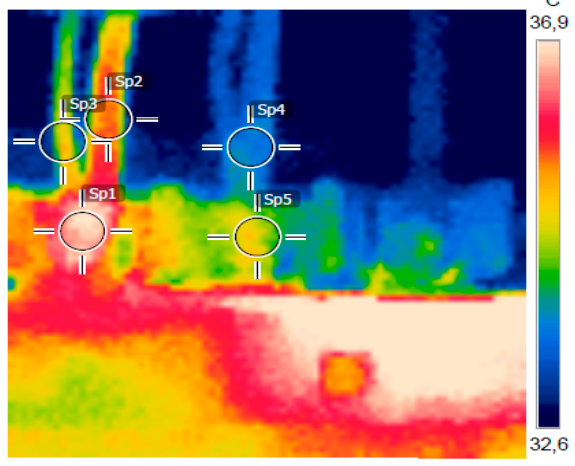
Figure 14. Thermographic analysis. Table 11. Results of the thermographic analysis before and after the operation of the photovoltaic